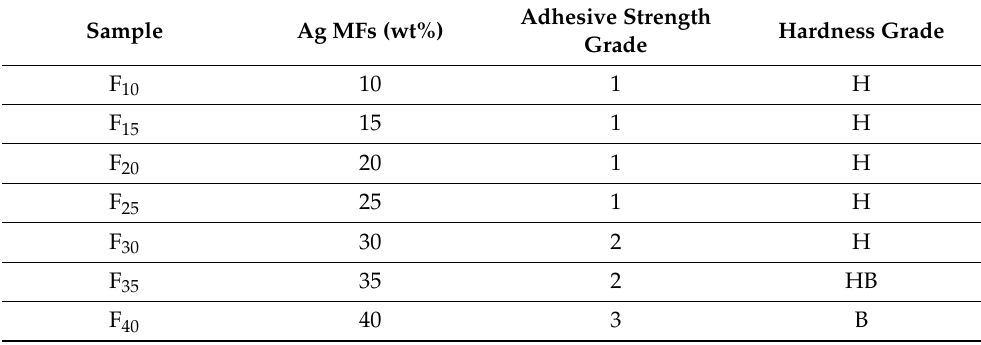
Adhesive Strength Hardness Grade Grade